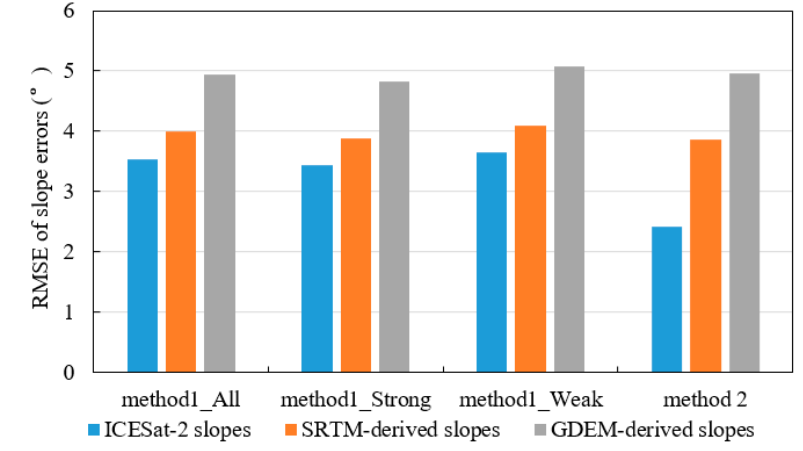
Figure 7. The RMSE of ICESat-2 estimated slopes, SRTM-derived slopes, and GDEM-derived slopes.